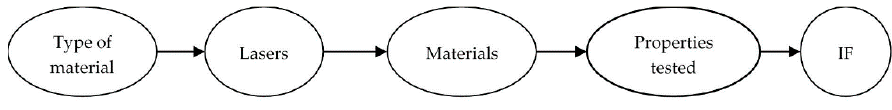
Figure 5. Bayesian network for expert knowledge.